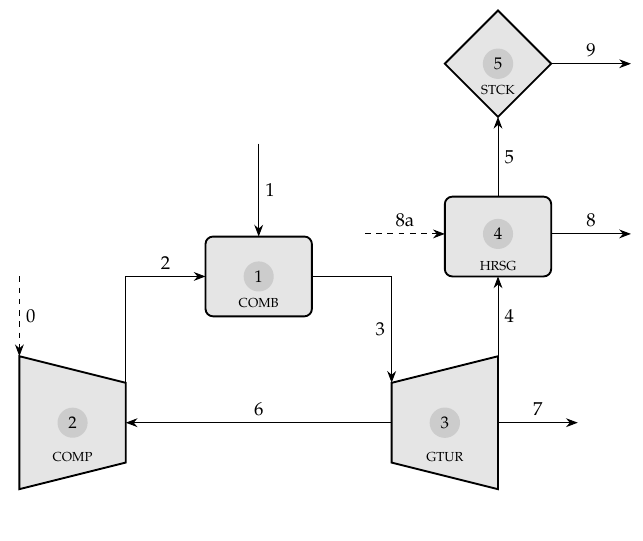
Figure 1. Flowsheet of TGAS